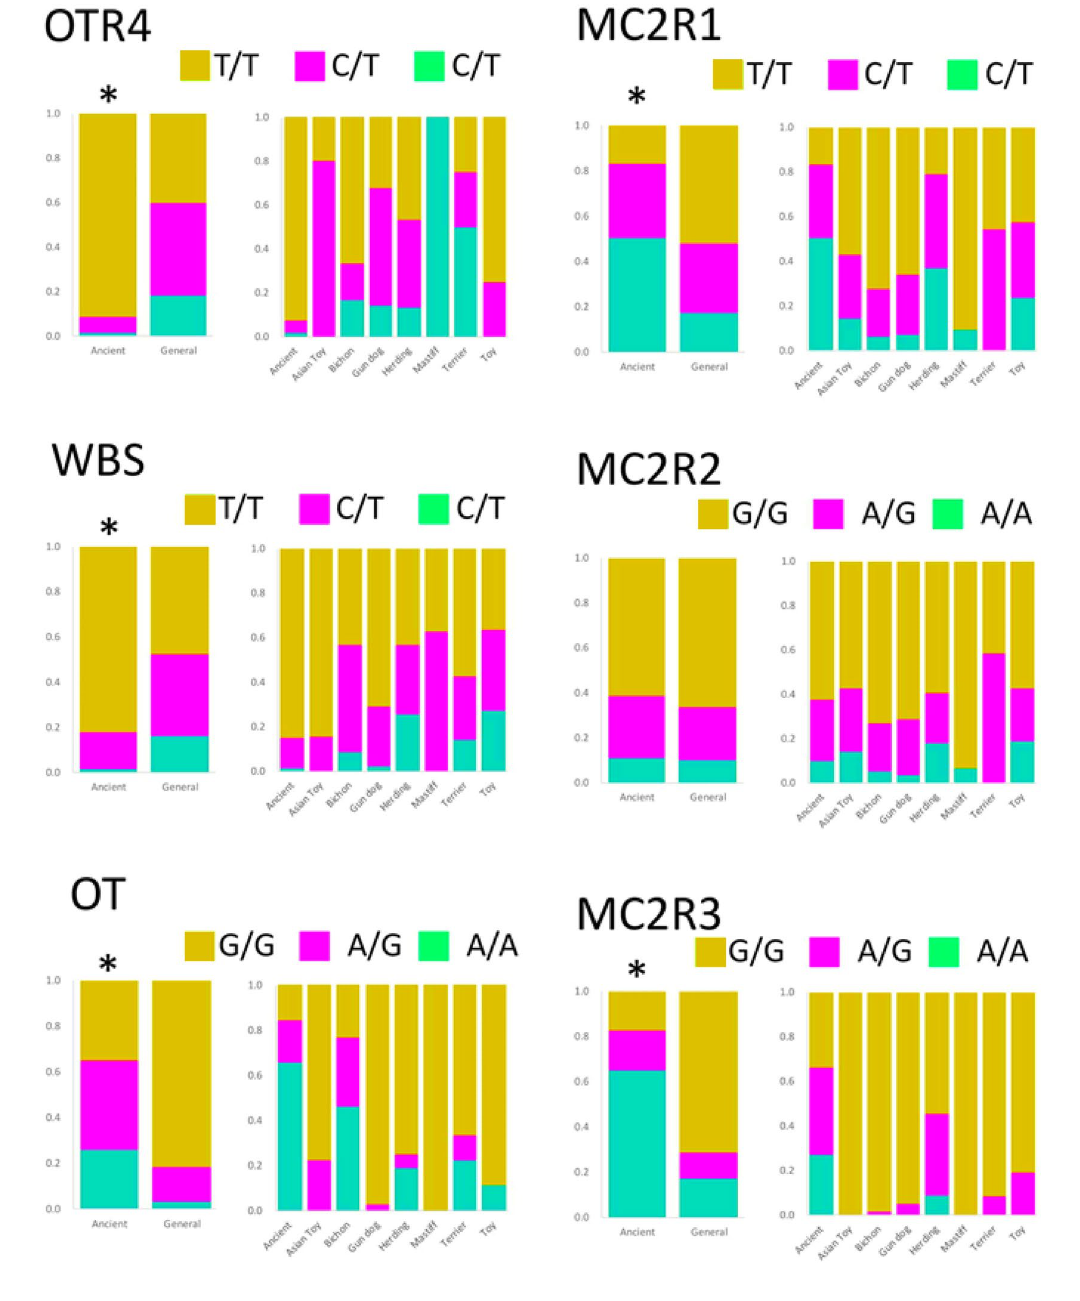
Figure 2. Breed comparisons of the allelic frequencies of six single-nucleotide polymorphisms (SNPs) of the candidate genes. All SNPs except MC2R SNP2 showed differences between the Ancient and General breed groups. * p < 0.05 (Chi-square